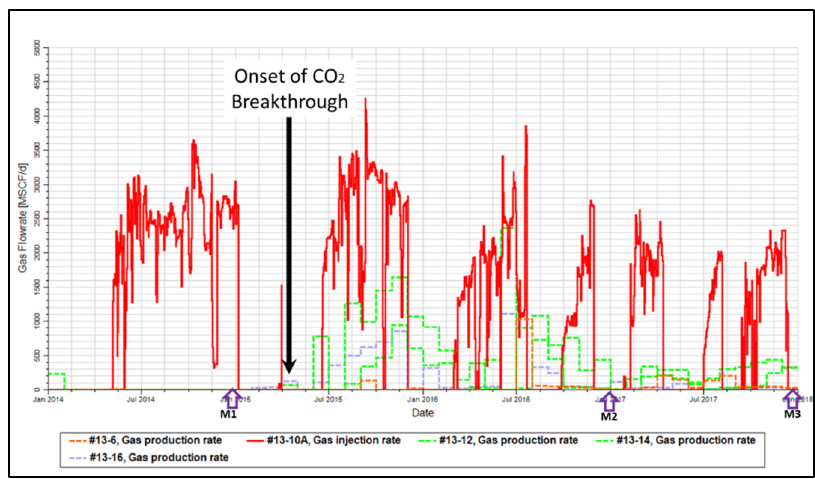
Figure 12. Gas injection and production in 13-10A pattern. CO 2 breakthrough occurs in early 2015 just after M1.